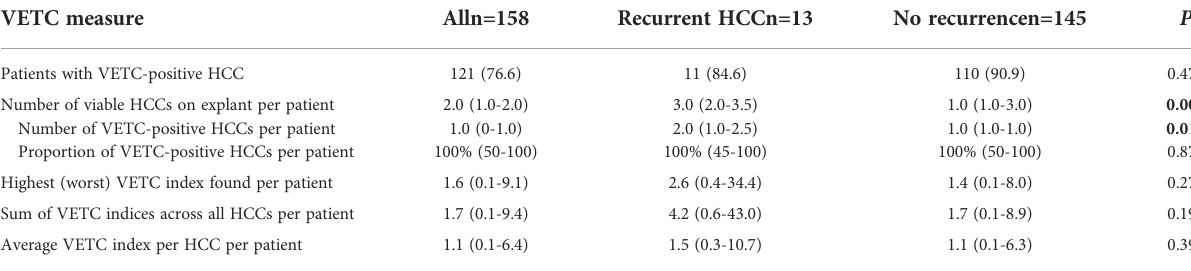
TABLE 2 Various quanti fi cations of VETC in patients with and without recurrent HCC. VETC